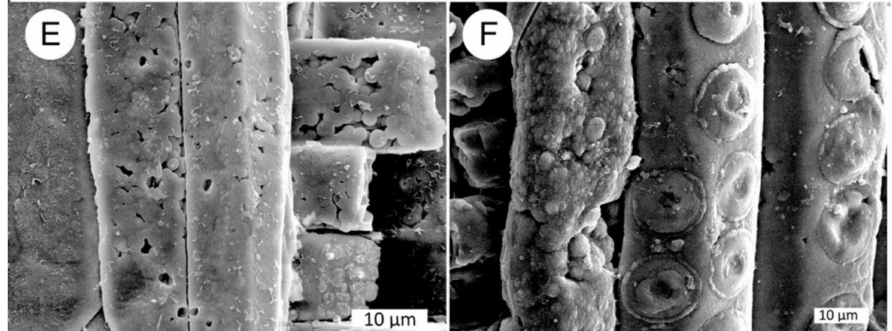
Figure 24. Opal-A in fossil wood from Miocene locations in Nevada, USA, showing lepisphere archi- tecture. ( A ) Loosely-packed lepispheres lying on silicified wood cells, seen in transverse orientation. Cecilly Ann Claim, Virgin Valley, Humbldt County. ( B ) Schurz, Mineral County. ( C , D ) Tracheid cells replaced by opal-A lepispheres. Virgin Valley, Humboldt County. ( E ) Hazen, Churchill County. The perpendicular angles of the two sets of cells are typical of wood cut in a tangential orientation. The horizontal cells are “rays”, which increase the mechanical strength of the wood, reducing the risk of vertical splitting caused by the parallel alignment of the vertical tracheid cells. ( F ) Middlegate, Churchill County. The prominent circular “bordered pits” are characteristic of gymnosperm wood. Specimens ( A , C , D ) provided by John Church.